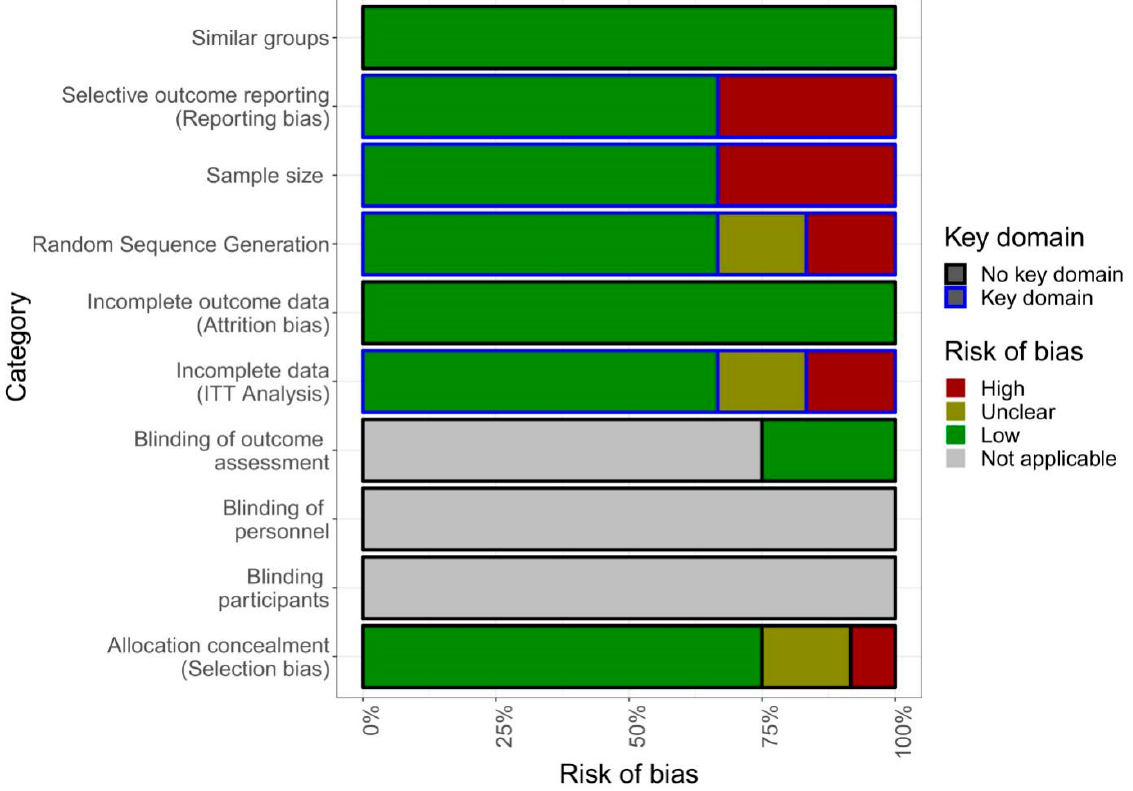
Figure 2. Risk of bias analysis. ITT, intent-to-treat